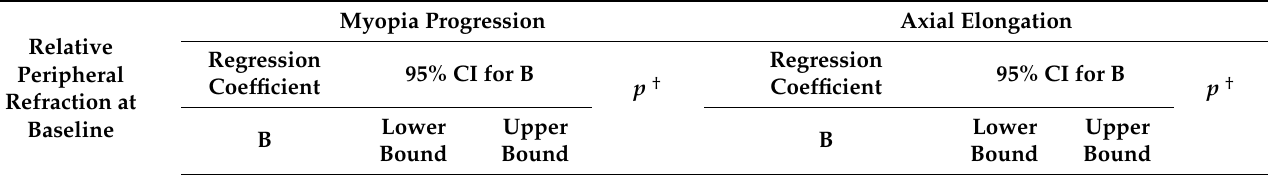
Table 1. Multiple linear regressions between relative peripheral refraction and myopia progression, axial elongation with relative peripheral refraction as the independent